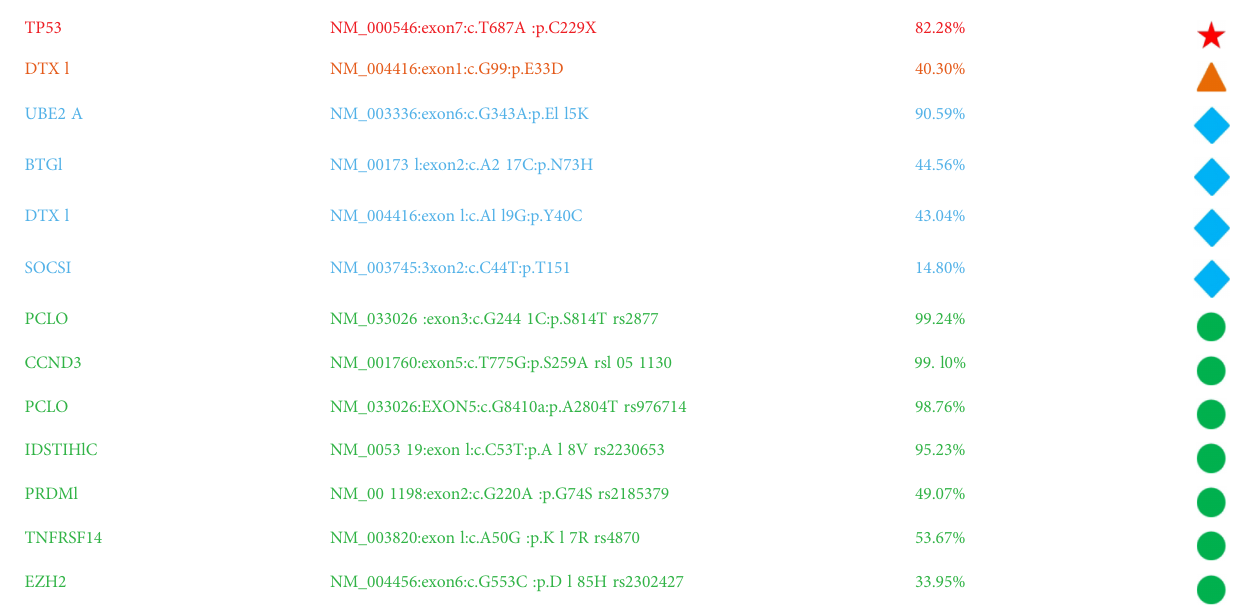
TABLE 1 Gene mutation result from NGS report. The 55 hot spot genes of DLBCL were screened.